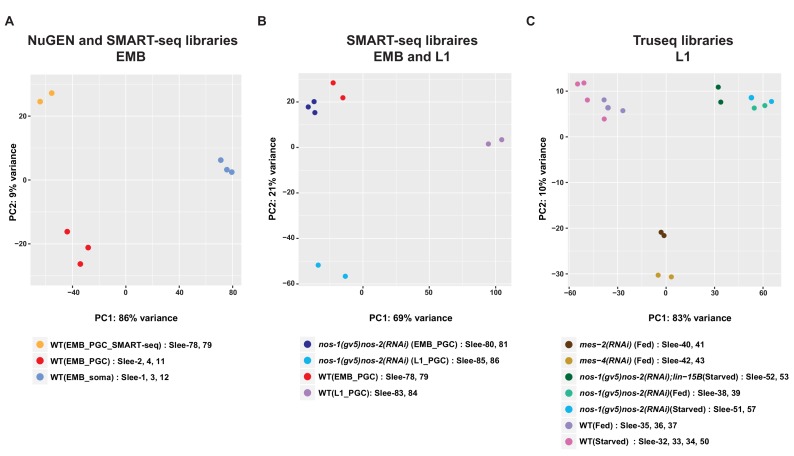
Principal component analysis (PCA) of transcriptomes from isolated PGCs.PCA of biological replicates from different development stages and library preparation methods across two principal components (PC1 and PC2). (A) PCA of embryonic samples [embryonic PGCs and somatic cells] using NuGEN or SMARTseq library preparation methods. (B) PCA of transcriptomes from embryonic or L1 PGCs. (C) PCA of transcriptomes from 17 L1 PGC samples.